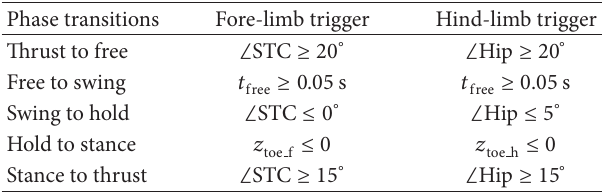
Figure 2: Phase diagrams of cheetah bounding controller. (a) Phase diagram for each leg. (b) Phase diagram for spine. Table 2: Phase transition rules of cheetah bounding.